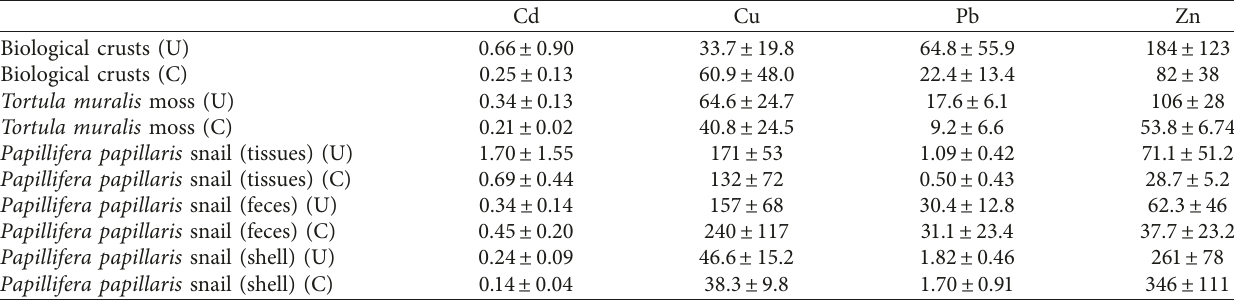
Table 2: Mean Cd, Cu, Pb, and Zn concentrations ( µ g · g − 1 ± SD) in biotic and abiotic matrices from Siena vegetated walls (U) and extraurban control walls